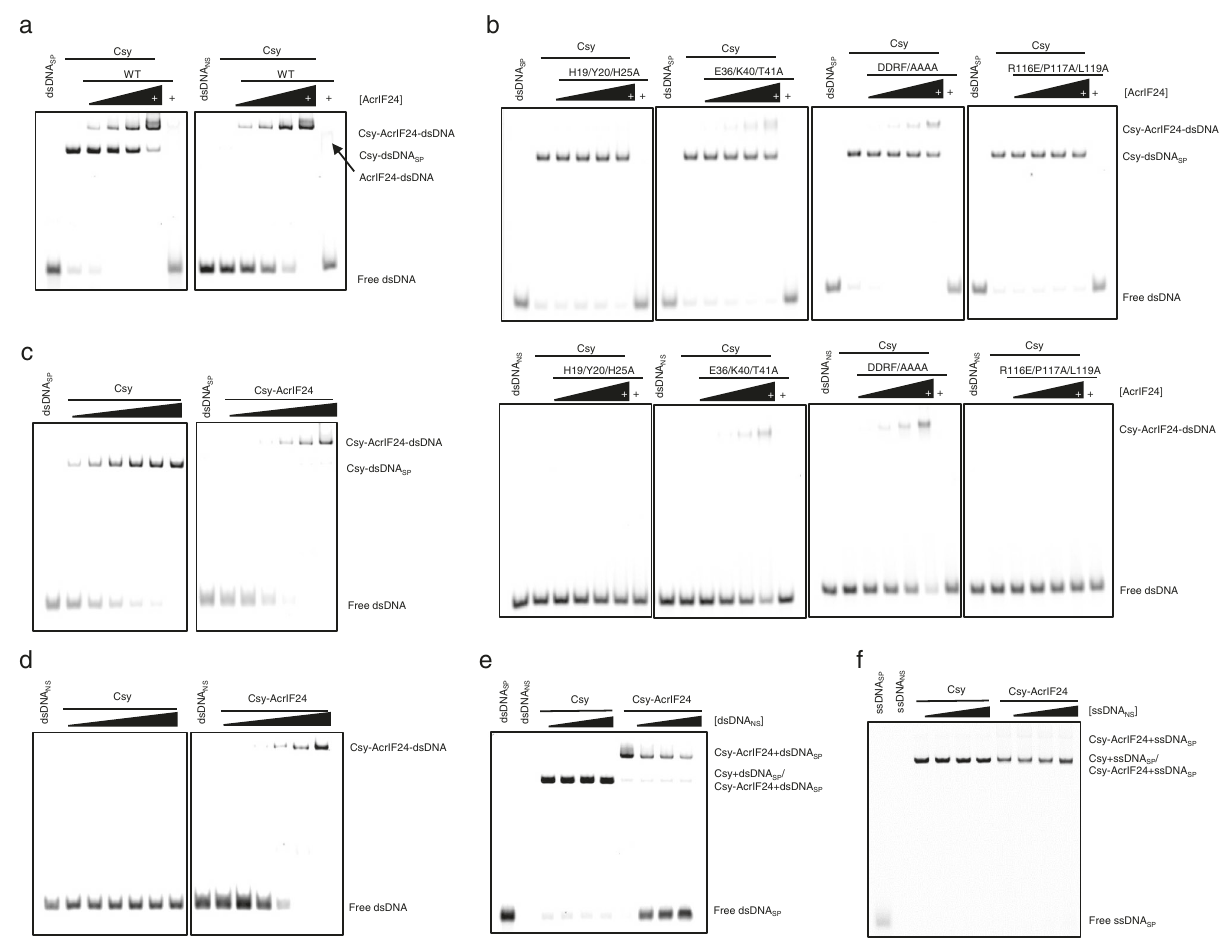
Fig. 5 AcrIF24 induces strong non-speci fi c DNA binding activity in the Csy complex. a EMSA was used to test the induction of non-speci fi c DNA binding by AcrIF24 using dsDNA SP and dsDNA NS . Reactions were performed with 1 μ M dsDNA SP or dsDNA NS , 8 μ M Csy, and concentrations of AcrIF24 were set as 1, 2, 4, and 8 μ M following the order indicated by the black triangle. The “ + ” represents 8 μ M of AcrIF24. b EMSA was used to test the induction of non- speci fi c DNA binding by AcrIF24 mutants using dsDNA SP and dsDNA NS . Reactions were performed as in a . DDRF/AAAA represents the D104A/D105A/ R106A/F107A mutant. Please see the left and right panels of a for WT controls of the experiments using dsDNA SP and dsDNA NS , respectively. c – d EMSA was used to test the DNA binding of Csy complex and Csy-AcrIF24 using dsDNA SP ( c ) and dsDNA NS ( d ). dsDNA SP and dsDNA NS were added as 1 μ M, and the concentrations of Csy complex and Csy-AcrIF24 were set as 0.5, 1, 2, 4, 8, and 16 μ M following the order indicated by the black triangle. e EMSA was used to test the binding competition between dsDNA SP and dsDNA NS on Csy or Csy-AcrIF24 complex. Reactions were started with incubation of 1 μ M dsDNA SP and 10 μ M Csy or Csy-AcrIF24 complex, and dsDNA NS without FAM label was then added with concentrations of 5, 10, and 20 μ M following the order indicated by the black triangle. f EMSA was used to test the binding competition between ssDNA SP and ssDNA NS on Csy or Csy-AcrIF24 complex. Reactions were exactly the same as in e except that all DNA molecules involved were